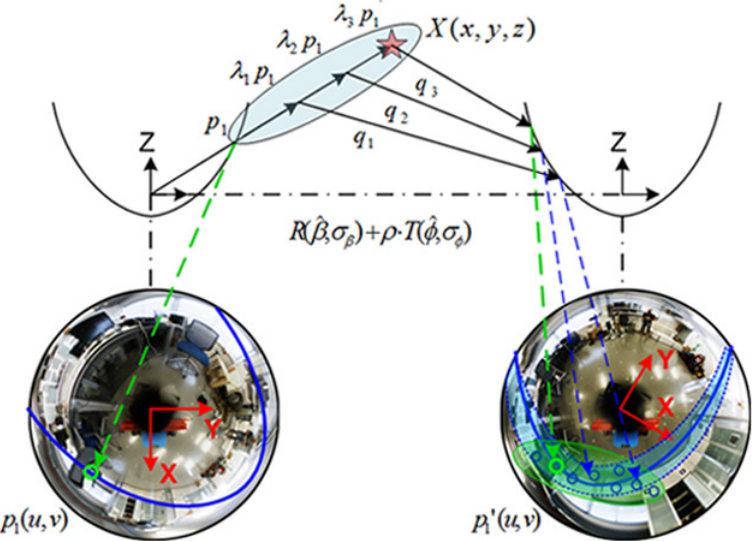
Figure 6. Adaptive matching: a feature point p 1 on the first image generates a multi-scaled distribution, λ i p 1 , to account for the lack of scale. Then it is transformed into q i on the second image through a rotation R ∼ N( ˆ β , σ β ), a translation T ∼ N( ˆ φ , σ φ ) and a scale factor ρ . Finally, q i is projected onto the second image plane to define a reduced area where matches must be searched. The circled points represent the projection of λ i p 1 (in the first image), as q i (in the second image). The epipolar curve transforms into a reshaped area due to the effect of the uncertainty propagation and the motion prediction, as per δ ( ˆ z t ) in Equation (14). Mahalanobis metric generates the final reshape on the feature descriptor space, denoted by the green